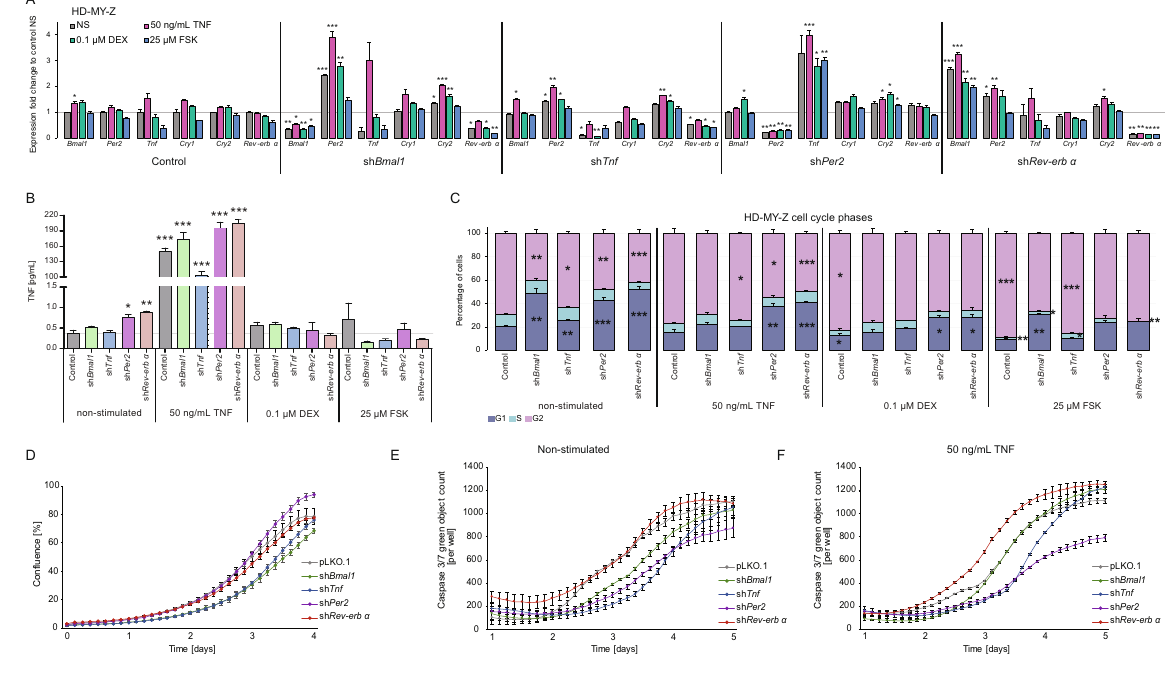
Figure 5. Dysregulation of the core-clock and of T nf led to differential cell cycle phenotypes in the HL cell line HD-MY-Z. ( A ) Gene expression qPCR data (n = 3, mean ± SEM). ( B ) TNF concentration in the supernatant (n = 3, mean ± SEM). ( C ) Cell cycle measurements after KD of Bmal1 , Tnf , Per2 and Rev-erb α followed by stimulation for 3 days with 50 ng/mL of recombinant human TNF, 0.1 µ M dexamethasone and 25 µ M of forskolin (n = 3, mean ± SEM). ( D ) Proliferation analyses of HD-MY-Z cell line after shRNA KDs. ( E , F ) Apoptosis analysis of HD-MY-Z cell line after KDs in both non-stimulated and TNF (50 ng/ml) stimulated conditions, respectively (n = 3, mean ± SEM). Statistics for the comparison to non-stimulated (NS) control * p < 0.05, ** p < 0.01, *** p <